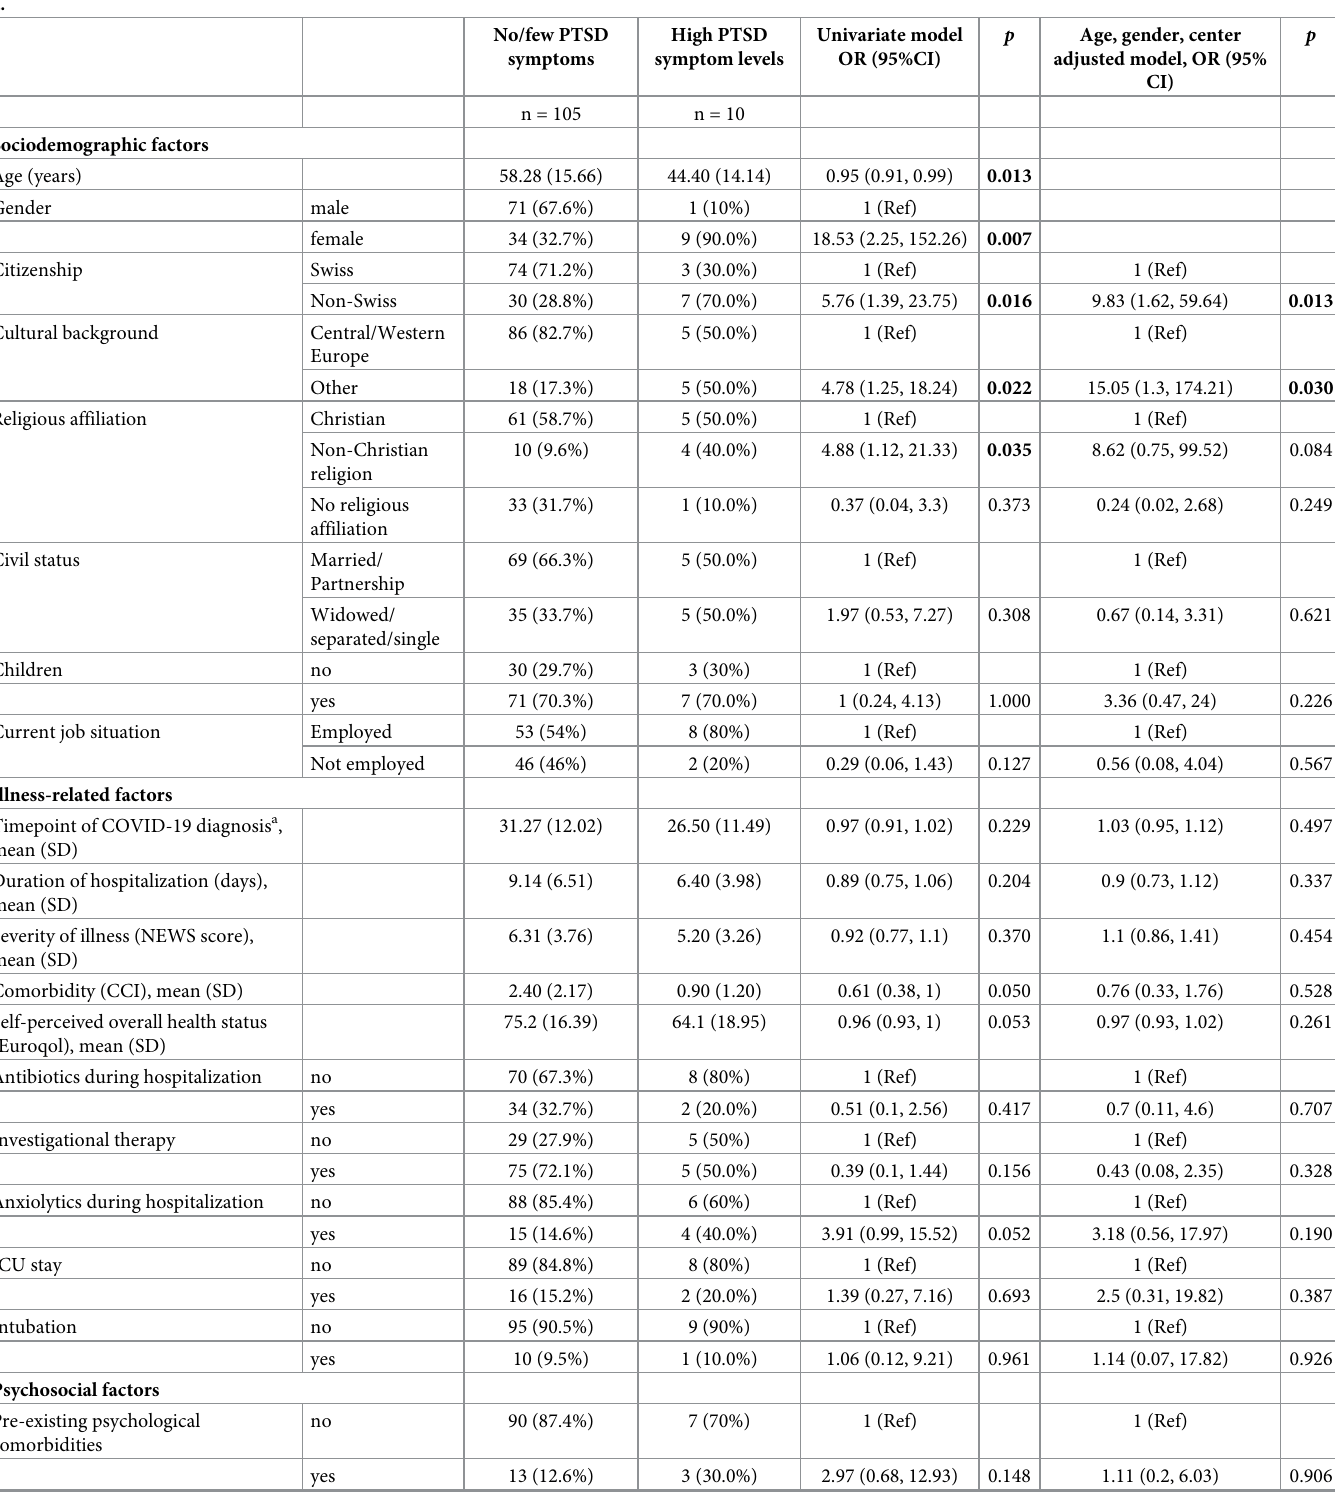
Table 4. Factors associated with high PTSD symptom levels in